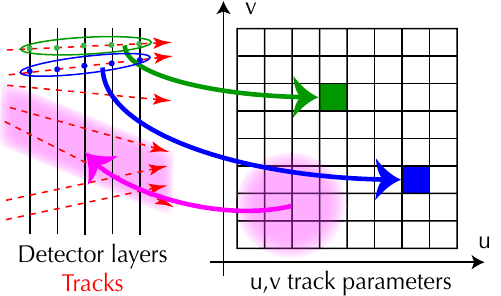
Figure 1: Retina mappings for tracks on a plane without magnetic field, where tracks can be described by two parameters u and v .